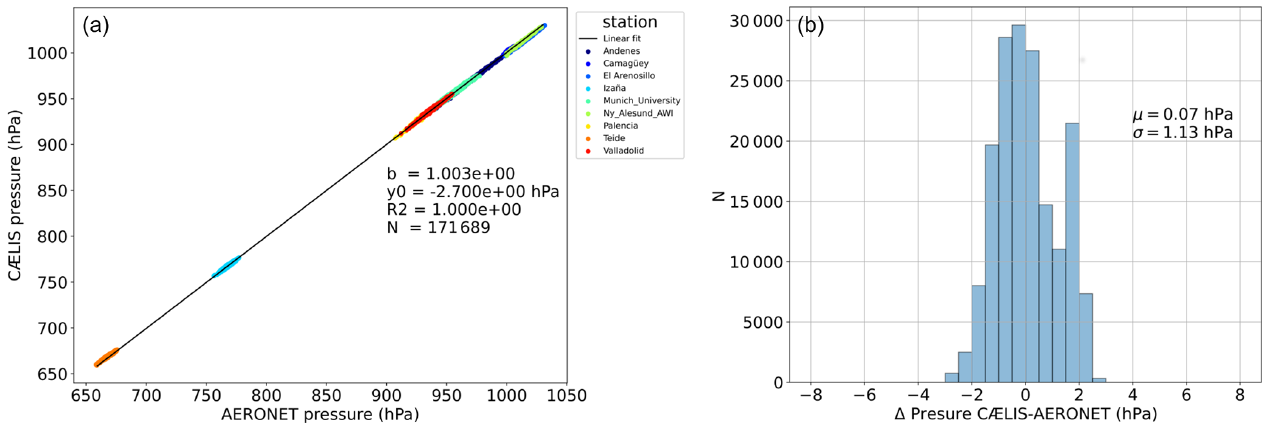
Figure 3. (a) CÆLIS atmospheric pressure as a function of AERONET atmospheric pressure for different stations. (b) Frequency histogram of the atmospheric pressure differences between CÆLIS and AERONET databases for all